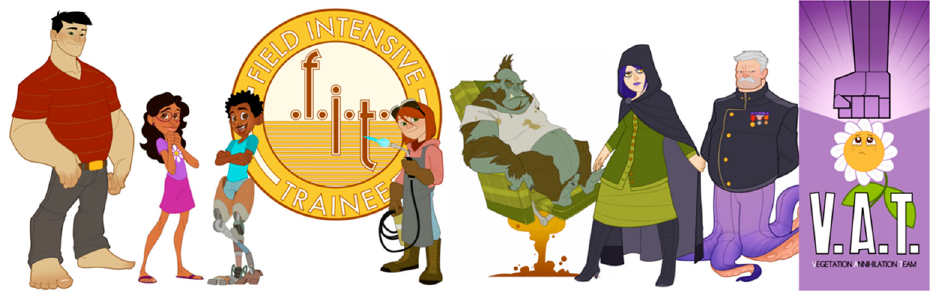
Figure 1. The four heroic members of the field intensive trainees (FITs) and the three villainous members of the vegetation annihilation team (VAT). Reprinted with permission from Utah State University. Copyright 2017 and 2021, Utah State University.